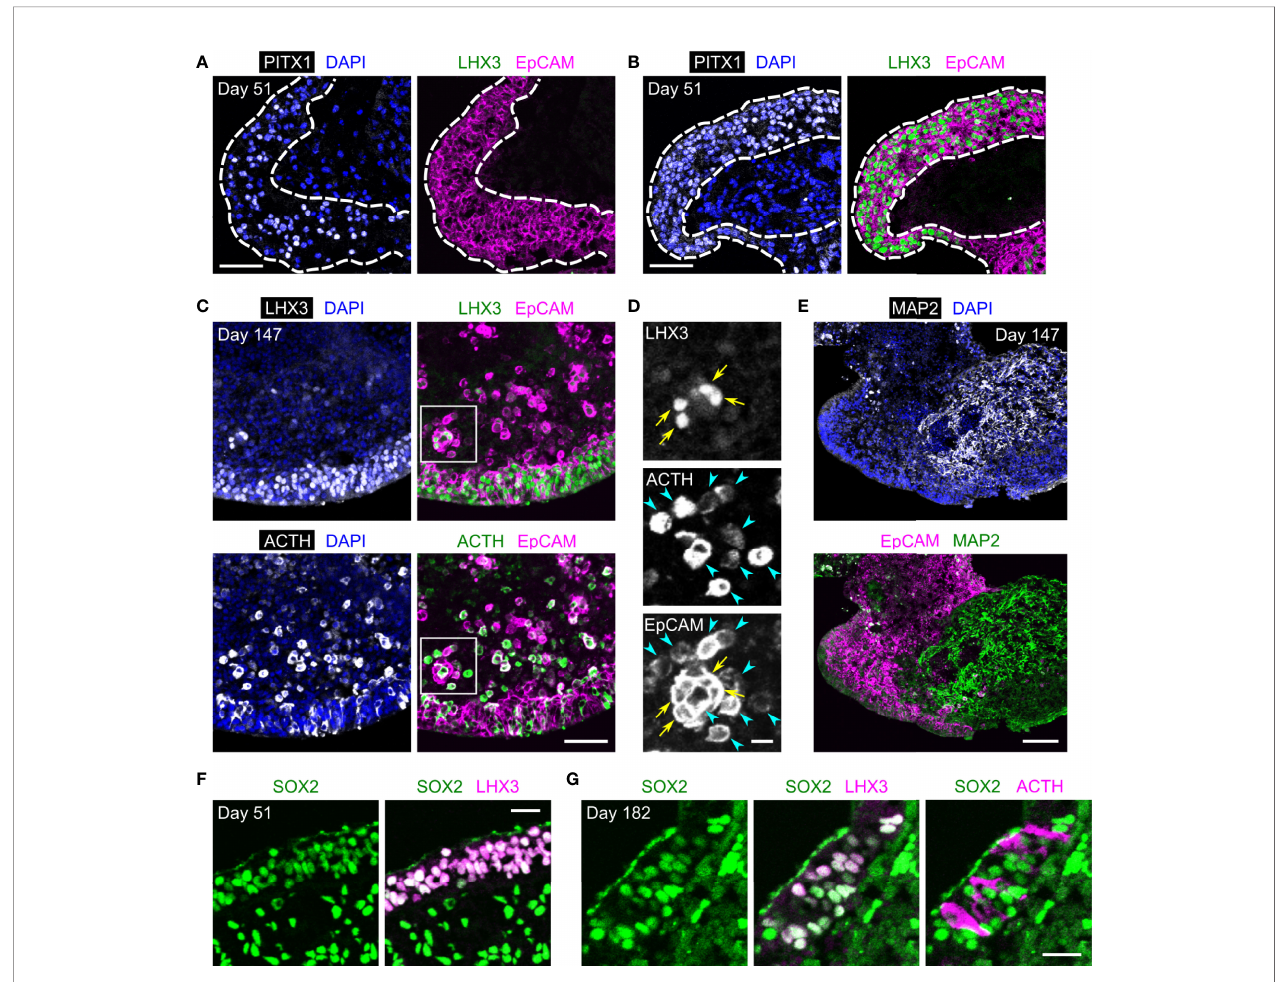
FIGURE 2 | The expression of EpCAM by anterior pituitary cells in HP organoids. (A, B) Triple immunostaining of a day-51 HP organoid for PITX1, LHX3, and EpCAM. Nuclei were stained with DAPI. Dashed lines show the surface layers of the organoid consisting of PITX1 + /LHX3 − OE cells (A) or PITX1 + /LHX3 + pituitary progenitors (B) , both of which express EpCAM. (C, D) Triple immunostaining of a day-147 HP organoid for LHX3, ACTH, and EpCAM. Magni fi ed views of the boxed region are presented by monochrome images in (D) . EpCAM is co-expressed with LHX3 (arrows) or ACTH (arrowheads). (E) Immuno fl uorescence images of a day- 147 HP organoid showing the mutually exclusive expression of MAP2 and EpCAM. (F) Double immunostaining of a day-51 HP organoid for SOX2 and LHX3. (G) Triple immunostaining of a day-182 HP organoid for SOX2, LHX3, and ACTH. Scale bars: 50 µm (A – C) , 10 µm (D) , 100 µm (E) , 20 µm (F, G)